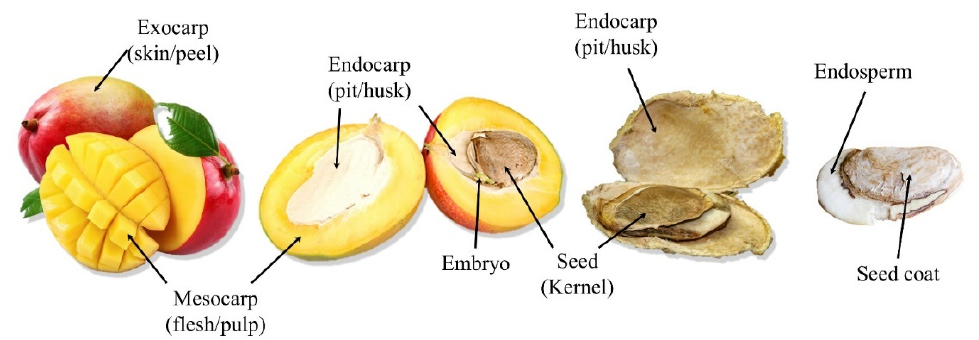
Figure 1. Anatomy of a typical mango fruit ( Mangifera indica L.).